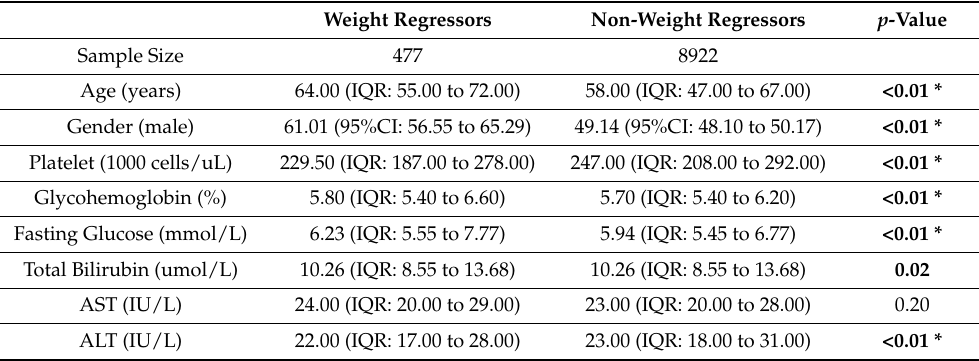
Table 2. Clinical Characteristics of Weight Regressors versus Individuals with Maintenance of Weight Class and Weight Progressors in a Population with NAFLD. Weight Regressors